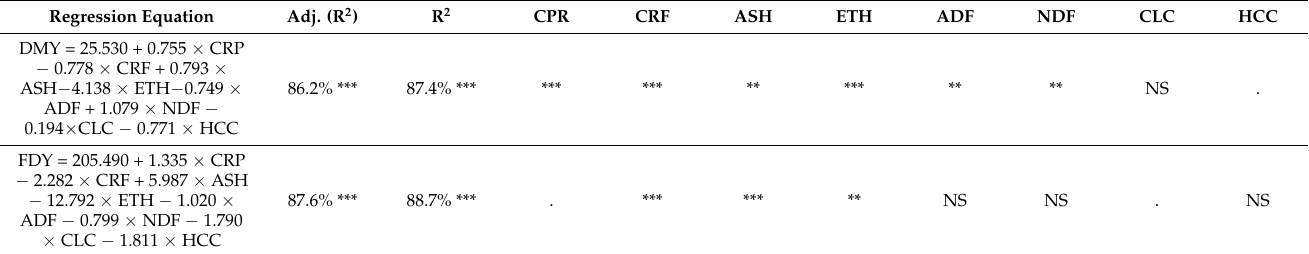
Table 7. Multiple linear regression equation of different sorghum quality traits on dry matter yield and fodder yield as affected by years, locations and P-K levels during 2015 and 2016. Regression Equation Adj. (R 2